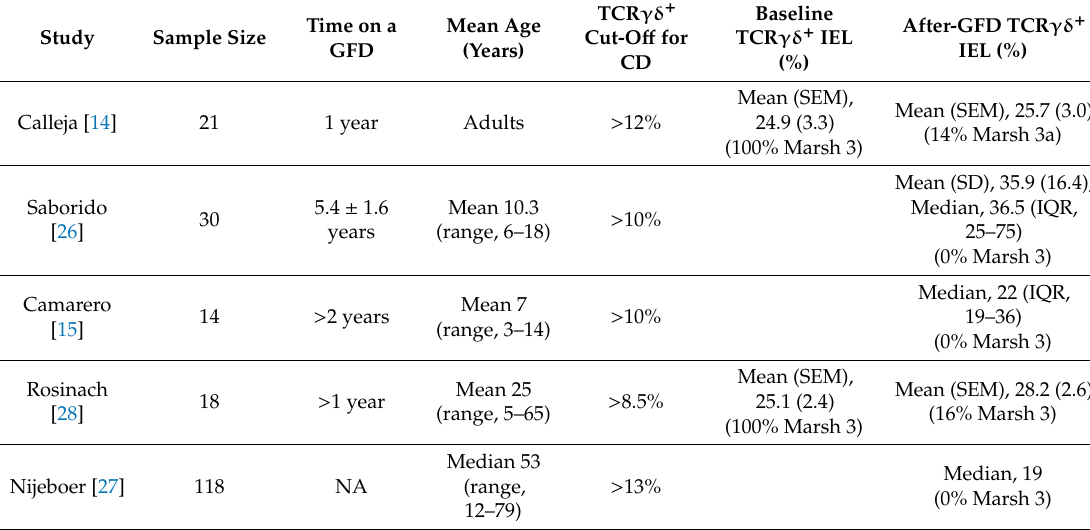
Table 4. TCR γδ + cells in CD patients following a long-term